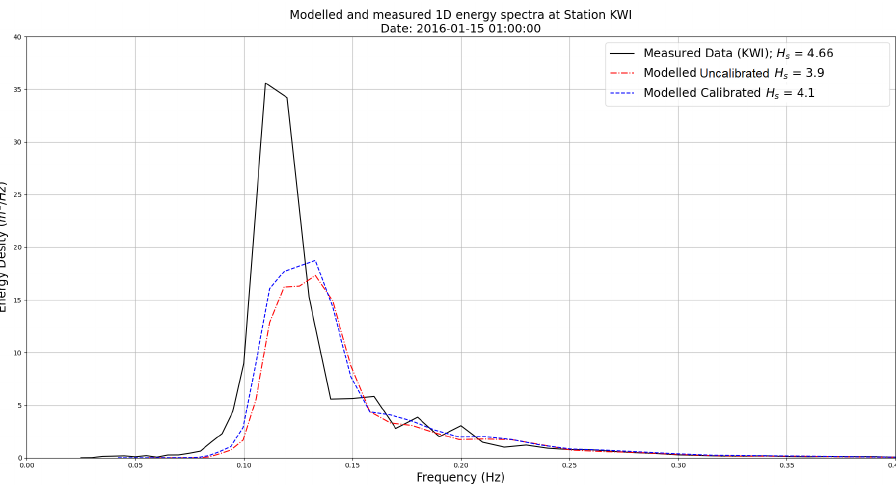
Figure 10. Spectral comparison for the Kwintebank station on 21 November 2015 16:00 showing the uncalibrated and calibrated SWAN models forced with DOWA.